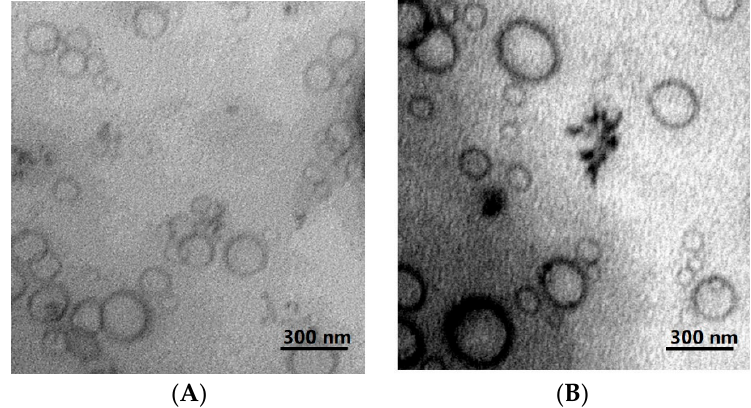
Figure 2. Transmission electron micrographs of FL-NDC-DP ( A ) and C-FL-NDC-DP ( B ).